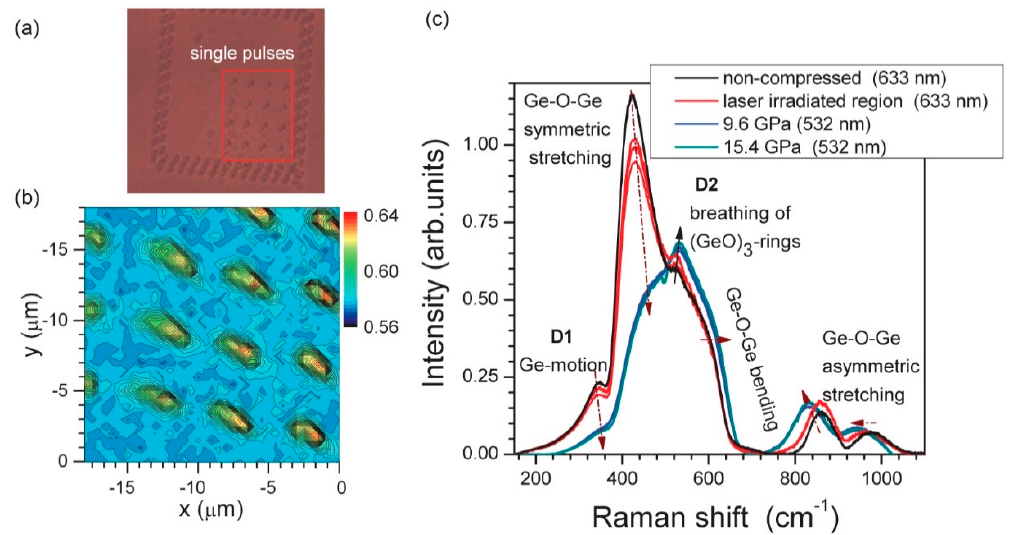
Figure 11. ( a ) An optical image of a GeO 2 region modified by single pulses of 300 nJ/pulse energy (at the entrance of microscope), 800 nm wavelength, and 150 fs pulse duration focused at 10 µm depth. ( b ) Map of the region boxed in ( a ) at the 520 cm − 1 D2-band, which corresponds to three-membered (GeO) 3 rings. ( c ) Raman spectra of laser irradiated regions at different pulse energies 200, 300, and 400 nJ and at different hydrostatic pressures, measured using 532 and 633 nm wavelength illumination. Arrows in ( c ) shows the observed tendencies with increasing pulse energy and/or pressure. Wavelengths of laser irradiation for Raman measurements are denoted in the legend of ( c ). Reproduced from [97]. Copyrights OSA 2011.